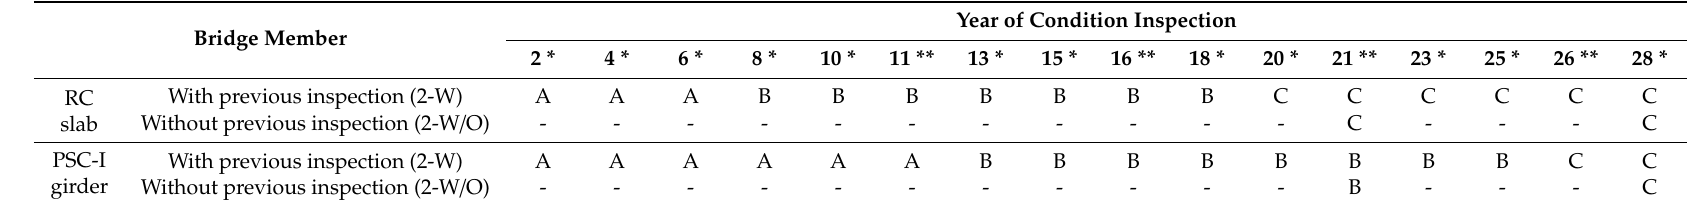
Table 7. Condition level of an RC slab and PSC-I girder (inspection type